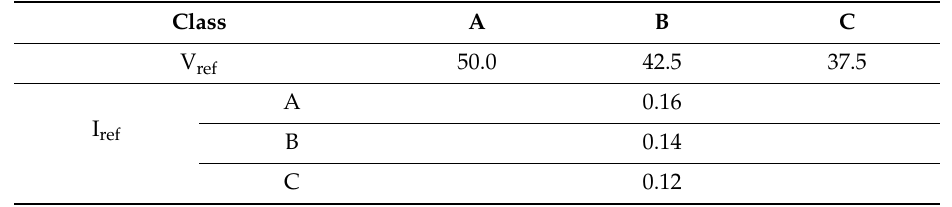
Figure 17. The relationship between turbulence intensity (TI) and wind speed at the wind turbine hub height (78 m above the ground surface) for Case4. Dots: simulation results from the present study. Lines: IEC (International Electrotechnical Commission) turbulence categories A, B, and C from the NTM (normal turbulence model), defined in IEC 61400-1 Ed.3 (2005). Table 2. Wind turbine class by IEC 61400-1 Ed.3 (2005). V ref is the 50-year return period values with 10-min average wind speed; I ref is the expected value of TI for a wind speed of 15 m/s.